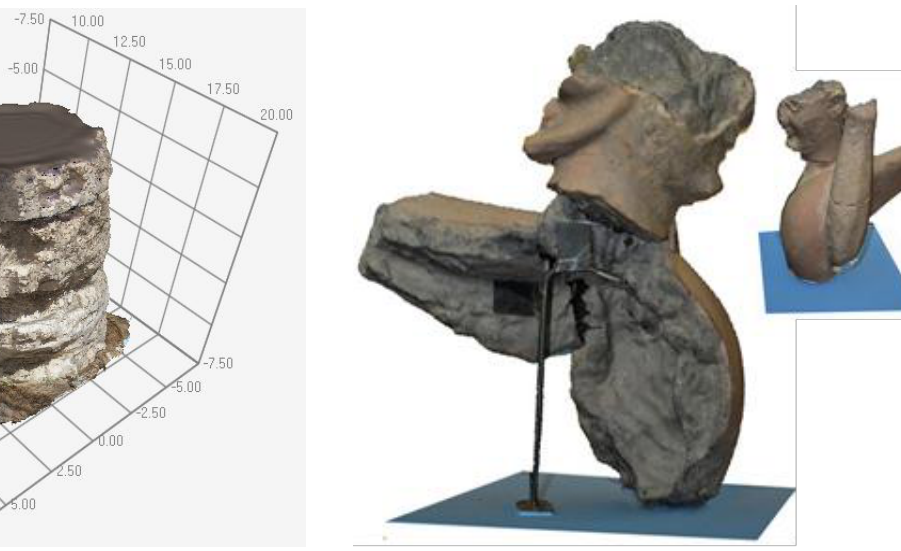
Figure 17. 3D model of the column in the reference grid